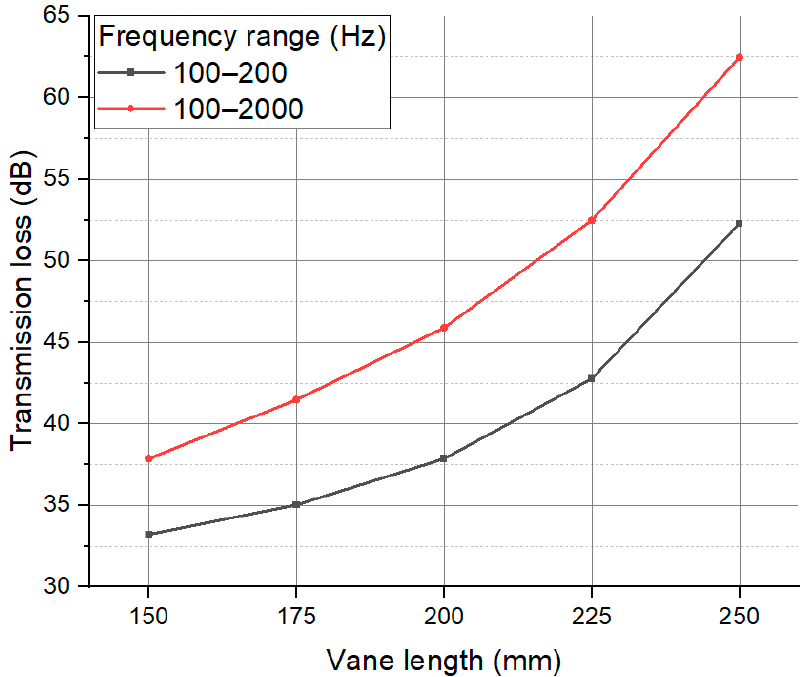
Figure 16. Transmission loss according to the vane length in the outer vane type.